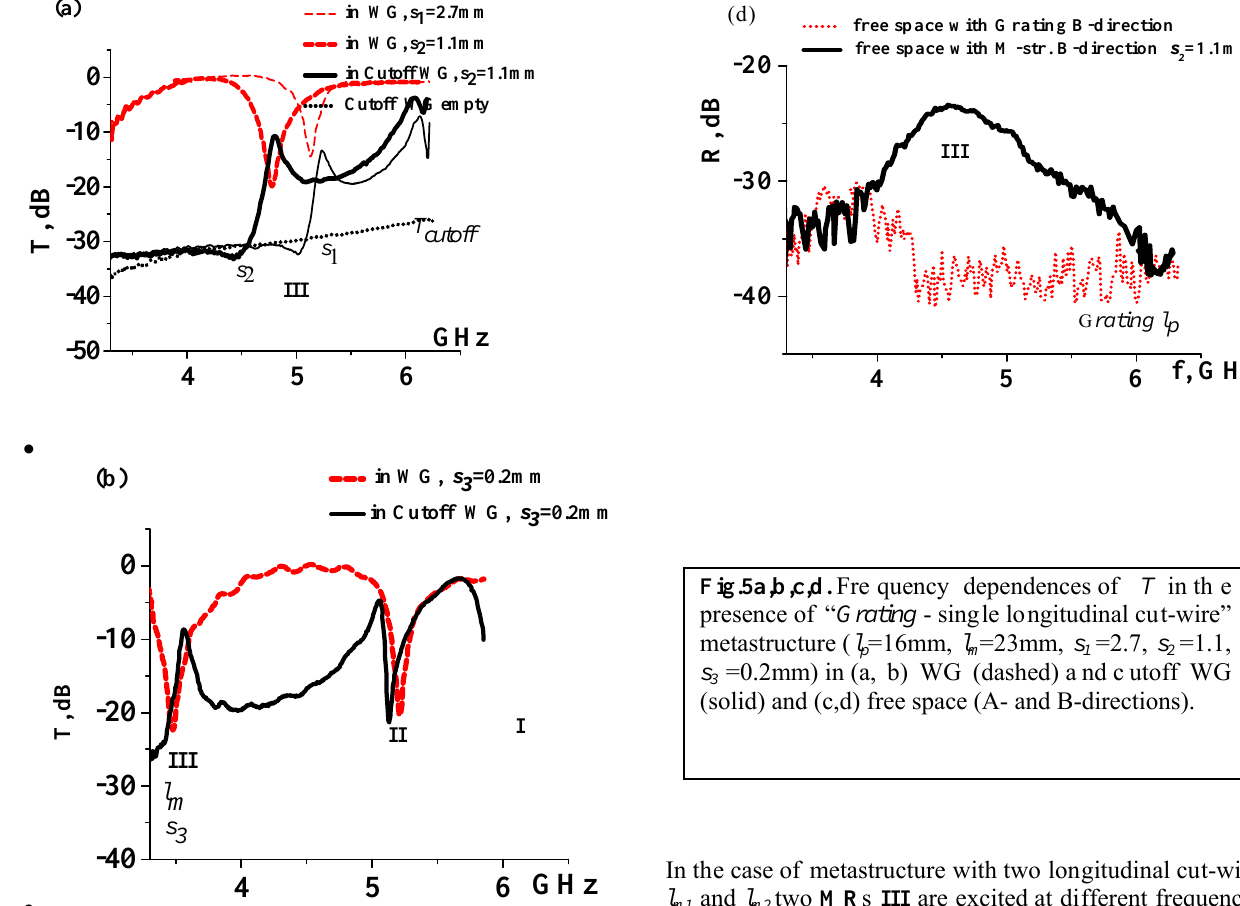
In the case of metastructure with two longitudinal cut-wires l MR s III are excited at different frequencies l m1 and m2 two and two corresponding pass-bands (in cutoff WG section) appear above the resonances III ( fig. 6 ). Resonance MRIII at f requency 4 .1GHz is prov ided b y wire l m1 =25mm and resonance at fre quency 5 .3GHz i s provided by w ire